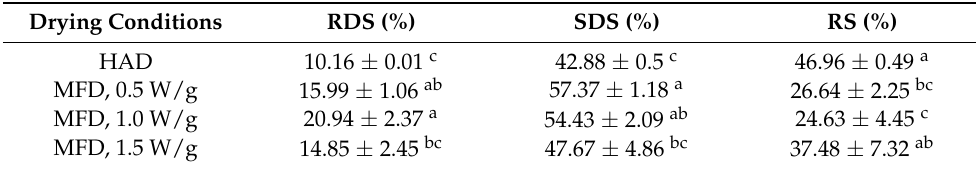
Table 5. The starch digestibility of yam flours dried by HAD and MFD. Drying